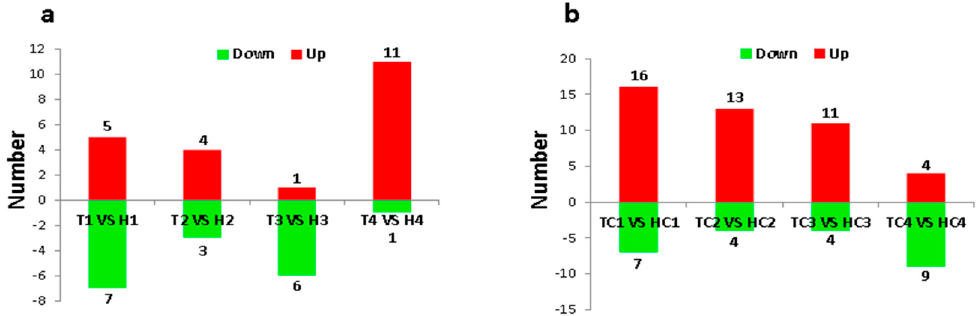
Figure 1. Histograms of differentially expressed microRNAs (miRNAs) under normal temperature (NT) and high temperature (HT) conditions. ( a ) The number of differentially expressed miRNAs in the anthers between HT-tolerant line and the HT-sensitive line under HT stress at sporogenous cell proliferation (SCP) (H1 vs. T1), meiotic phase MP (H2 vs. T2), microspore release period MRP (H3 vs. T3), and pollen maturity (PM) (H4 vs. T4) stages. ( b ) The number of differentially expressed miRNAs